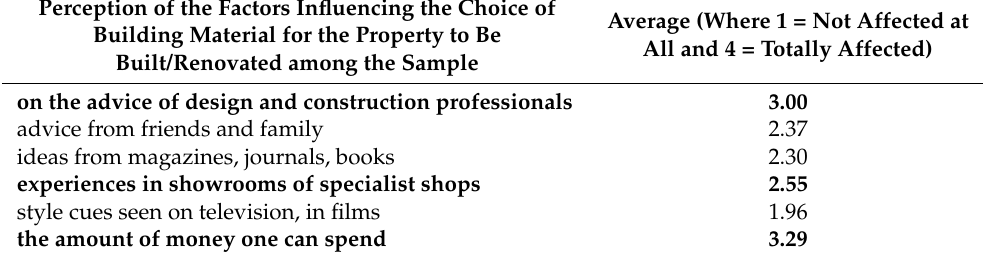
Table 3. Perception of factors influencing material use (average, where 1 = not at all, 4 = totally affected). Perception of the Factors Influencing the Choice of